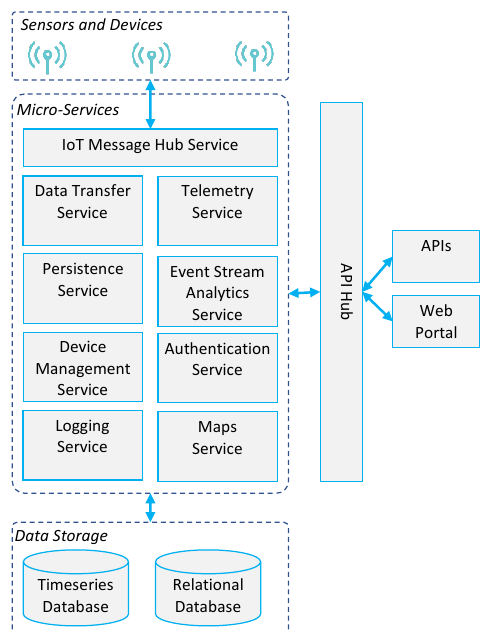
Figure 5 . Architecture of the data